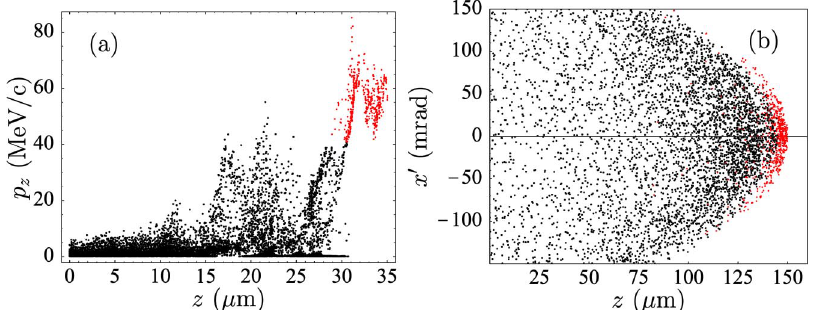
FIG. 18. (Color) z (cid:6) p phase-space projection of a 3D electron distribution (a) after a laser propagation distance of (cid:4) 530 (cid:4) m inside z a homogeneous preionized plasma and (b) z versus beam divergence x 0 after a propagation of 5 : 3 mm in vacuum. The laser-plasma (cid:1) 0 : 8 (cid:4) m , pulse duration (cid:12) (cid:1) L=c (cid:1) 55 fs , spot size at waist r parameters were a laser strength a (cid:1) 2 : 2 , carrier frequency (cid:1) 0 (cid:1) 4 (cid:5) 10 19 cm (cid:6) 3 . 7 : 4 (cid:4) m , and nominal density n 0